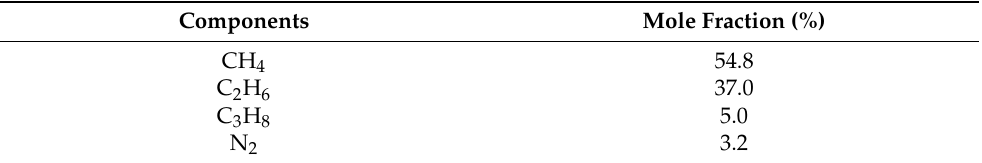
Table 2. Components of the gas associated with the crude oil.